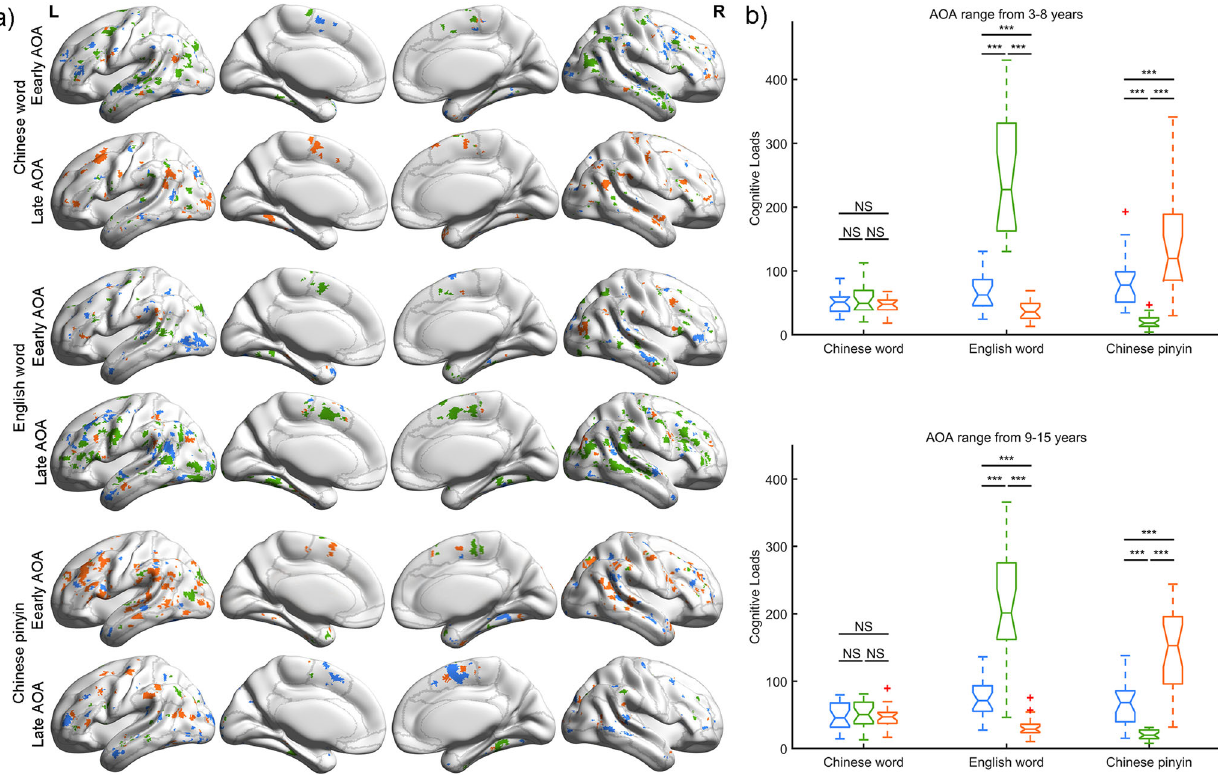
Fig. 8 Brain loads for three linguistic components in early and late AOA participants. a Brain involvement maps of three linguistic components in early and late AOA participants respectively among language types. Gray lines indicate the regional boundaries. b Two-way repeated ANOVA was performed, and signi fi cant differences were found between linguistic components and language types in early and late AOA participants respectively. Post hoc analysis shows differentiated patterns of brain activity elicited by language-processing components for English word and Chinese pinyin. *** p < 0.001; NS, non- signi fi